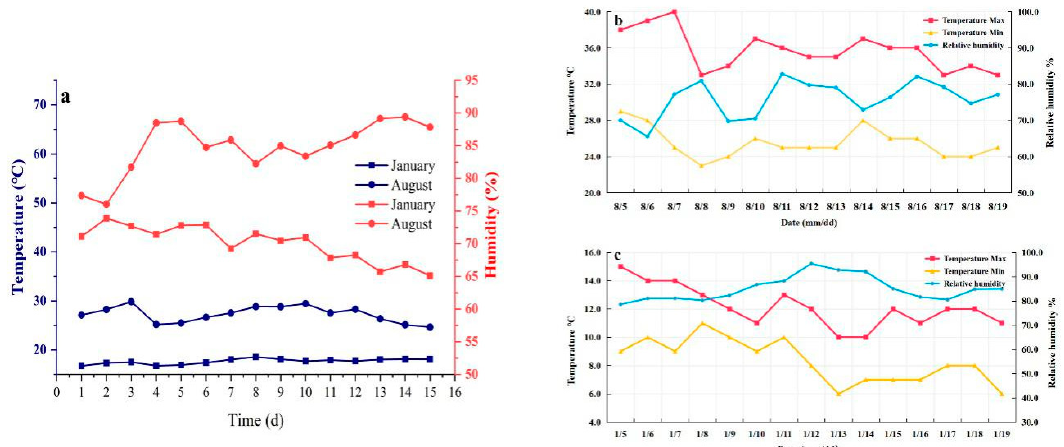
Figure 3. Ambient temperature and relative humidity ( left ) ( a ), and indoor temperature and relative humidity ( right ) ( b , c ), of the monitoring periods.